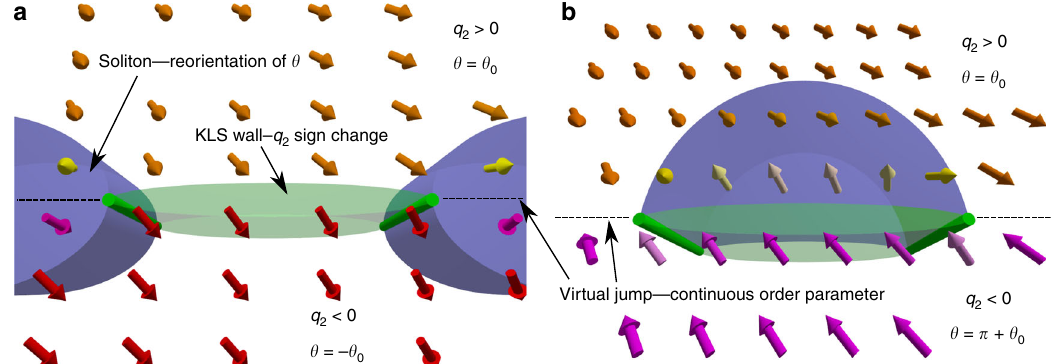
Fig. 4 Kibble – Lazarides – Sha fi (KLS) wall con fi gurations in the PdB phase. Each HQV core terminates one soliton — reorientation of the spin part of the order parameter denoted by the angle θ — and one KLS wall. The orientation of the b d -vector is shown as arrows where their color indicates the angle θ , based on numerical calculations (Supplementary Figure 2). a The KLS wall is bound between a different pair of HQV cores as the soliton. Ignoring the virtual jumps, the angle θ winds by π − 2 θ 0 across the soliton and by 2 θ 0 across the KLS wall. The order parameter is continuous across the virtual jumps, where ϕ → ϕ + π , θ → θ + π , and q → − q 2 2 . b The soliton and the KLS wall are bound between the same pair of HQV cores. The total winding of the structure. In principle, the KLS wall may lie inside or outside the soliton. Here the KLS wall and the soliton are spatially separated for ^ d and ^ e 1 along some direction in the plane perpendicular to the HQV core. In the presence of order-parameter components with q > 0, Eq. (4) remains single-valued if, and only if, q 2 also changes sign. We conclude that the resulting domain wall separates the ¼ ± q and together with the bounding degenerate states with q 2 HQVs has a structure identical to the domain wall bounded by strings — the KLS wall — proposed by Kibble, Lazarides, and Sha fi in refs. 22,28 . The KLS wall and the topological soliton have distinct de fi ning length scales 17,33 — the KLS wall has a hard core of the order of